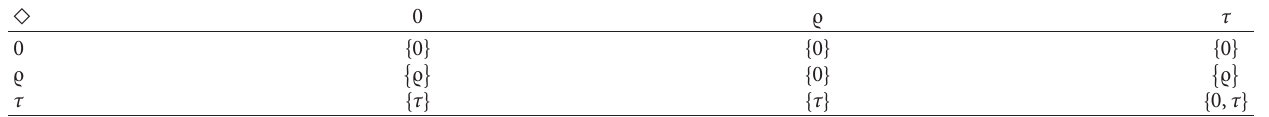
Table 5: Tabular representation of W � ( M